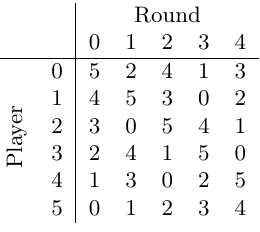
Table 2: A round-robin tournament of order 6.